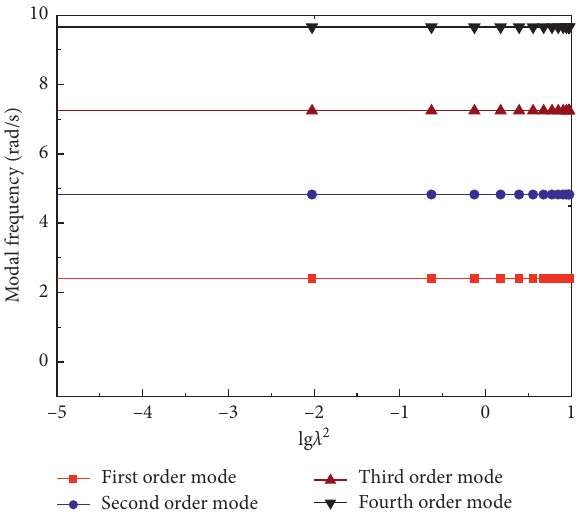
Figure 9: Relationship between out-of-plane modal frequency and sag of tether.